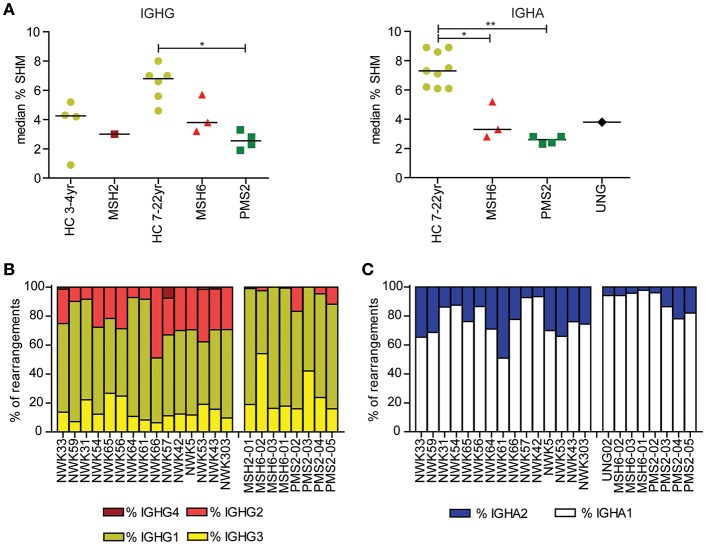
Mutations in MMR and BER proteins lead to reduced frequency of SHM. (A) Median SHM frequency in IGHG and IGHA rearrangements is reduced in UNG-, MSH2-, MSH6-, and PMS2-deficient patients compared to HCs. Frequency of IGHG (B) and IGHA subclasses (C). Patients with UNG-, MSH2-, MSH6-, and PMS2-deficiency have more IGG1, IGG3, and IGA1 rearrangements compared to HCs. Statistical significance was performed using a Mann–Whitney test and indicated using *P < 0.05 and **P < 0.01.